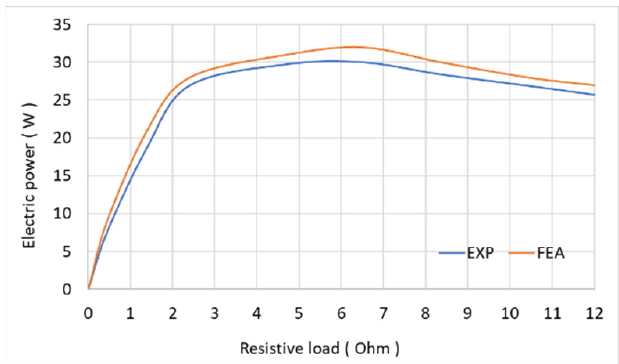
Figure 28. Comparison of experimental (EXP) and simulated (FEA) results of electric power (rms) versus resistive load at 300 rpm ~ 0.5 m/s.